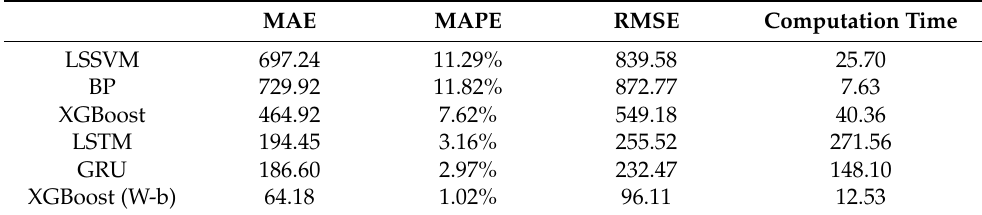
Figure 4. Load forecasting without considering real-time electricity prices. Table 5. The experimental error of each model (without considering the real-time electricity price).